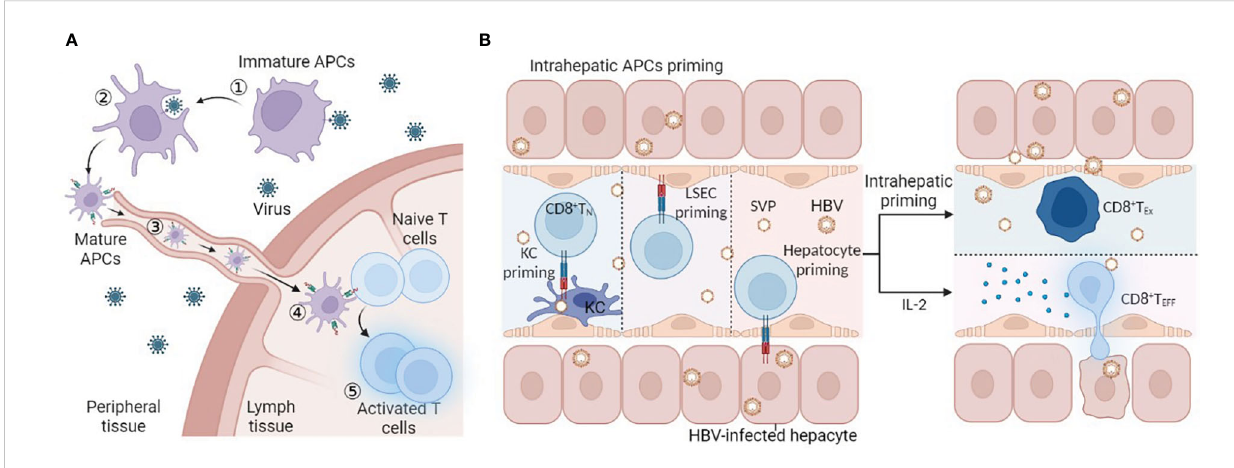
FIGURE 1 T-cell priming location. (A) ① Immature APCs recognize PAMPs in pathogens by PRRs, ② APCs phagocytose and process pathogens, ③ APCs mature and present peptides and migrate into LNs to connect naïve antigen-speci fi c T cells, ④ T-cell priming and activation, and ⑤ homing to the infected site. (B) Naïve HBV-speci fi c CD8 T cells circulate through the hepatic sinus and are primed by intrahepatic APCs (KC, LSEC, or hepatocyte). Intrahepatic priming may contribute to the exhaustion of CD8 T cells, and IL-2 can rescue and promote the differentiation of effector CD8 T cells. Abbreviations: APCs antigen-presenting cells, LSEC liver sinusoidal endothelial cell, KC, SVP spherical subviral particle, CD8 T N naïve CD8 T cell, CD8